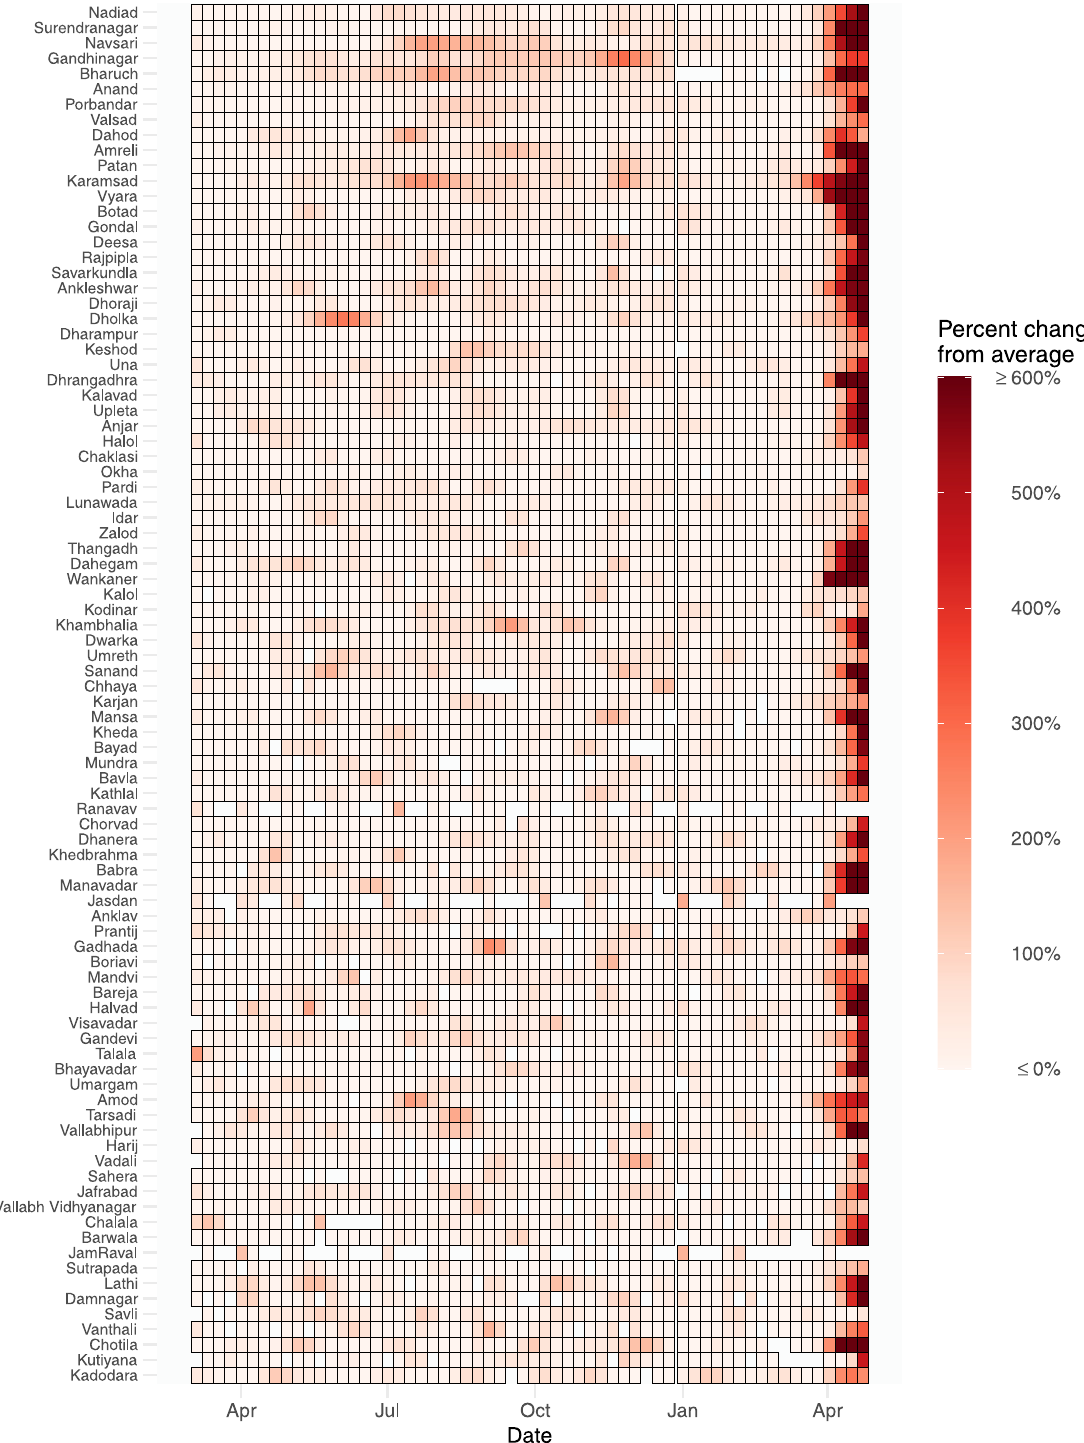
Fig 3. Estimated percent increase in mortality in the 90 municipalities, March 2020 to April 2021, from our marginal analysis.